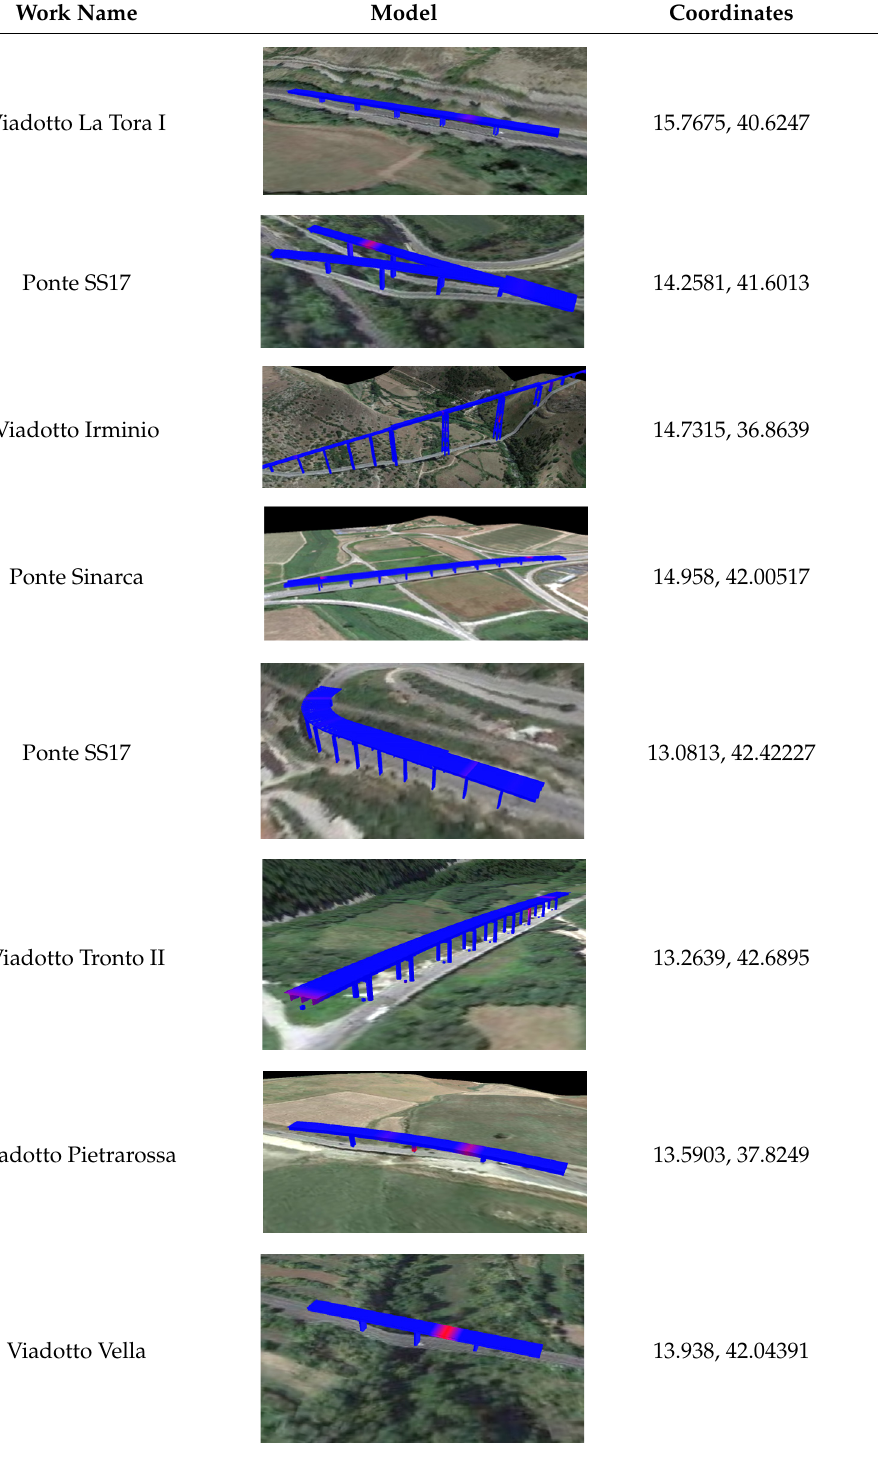
Table 1. Data of the Analyzed Works.